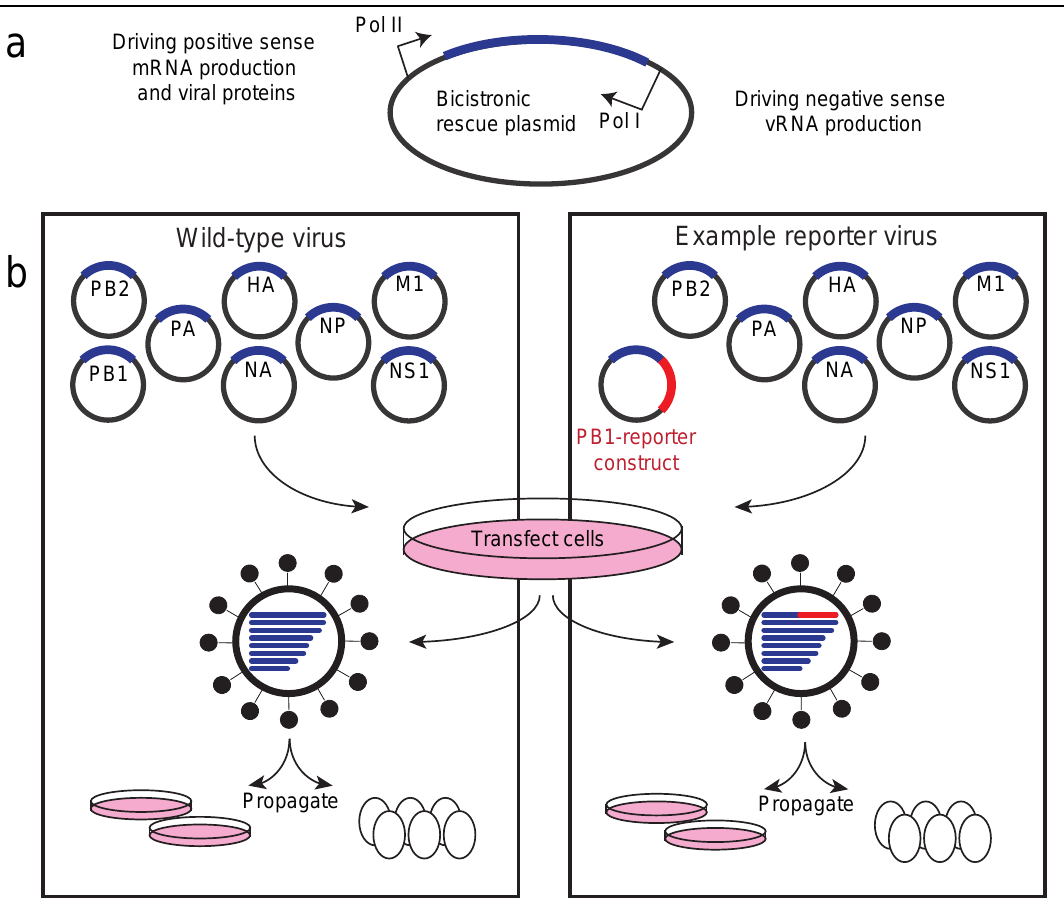
Figure 2. Schematic outlining influenza virus reverse genetic systems. ( a ) Bi-cistronic plasmid that drives expression of positive-sense viral mRNA for gene transcription and negative-sense viral RNA for genomic replication. ( b ) Transfection of an eight-plasmid system (one plasmid per viral genomic segment) allows production of recombinant wild-type virus. Alternatively, genomic segment plasmids containing reporter constructs can be introduced in place of wild-type (WT) segments to generate viruses harboring reporter genes.